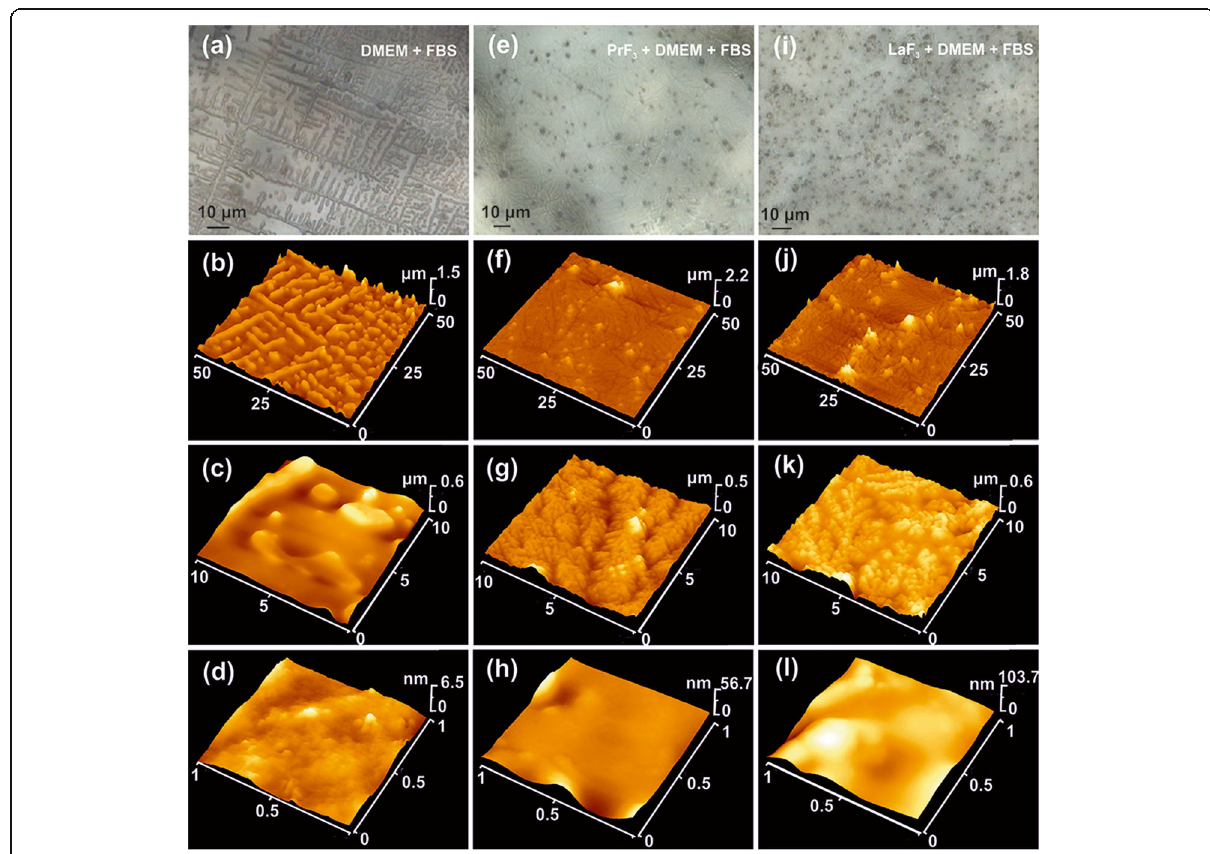
Fig. 5 AFM and optical images of dried RE-NPs in DMEM+FBS. a – d Optical ( a ) and AFM images ( b – d ) of DMEM+FBS showing 5 μ m self-assembled structures. e – h CCD ( e ) and AFM images ( f – h ) of PrF 3 NPs in DMEM+FBS media showing 500 nm dendrite-self-assembled structures. i – l CCD ( i ) and AFM images at different magnifications ( j – l ) of LaF 3 NPs in DMEM+FBS showing 100